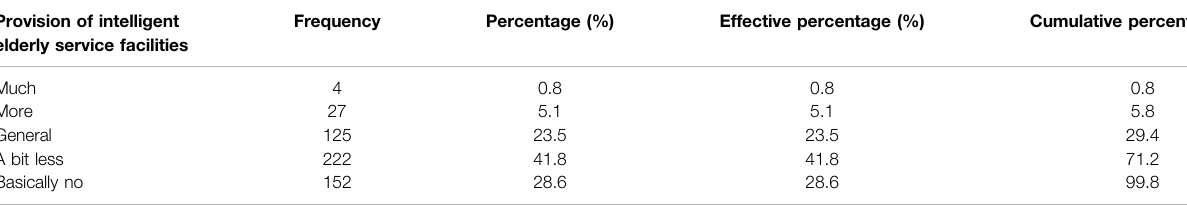
TABLE 6 | Provision of smart elderly service facilities.